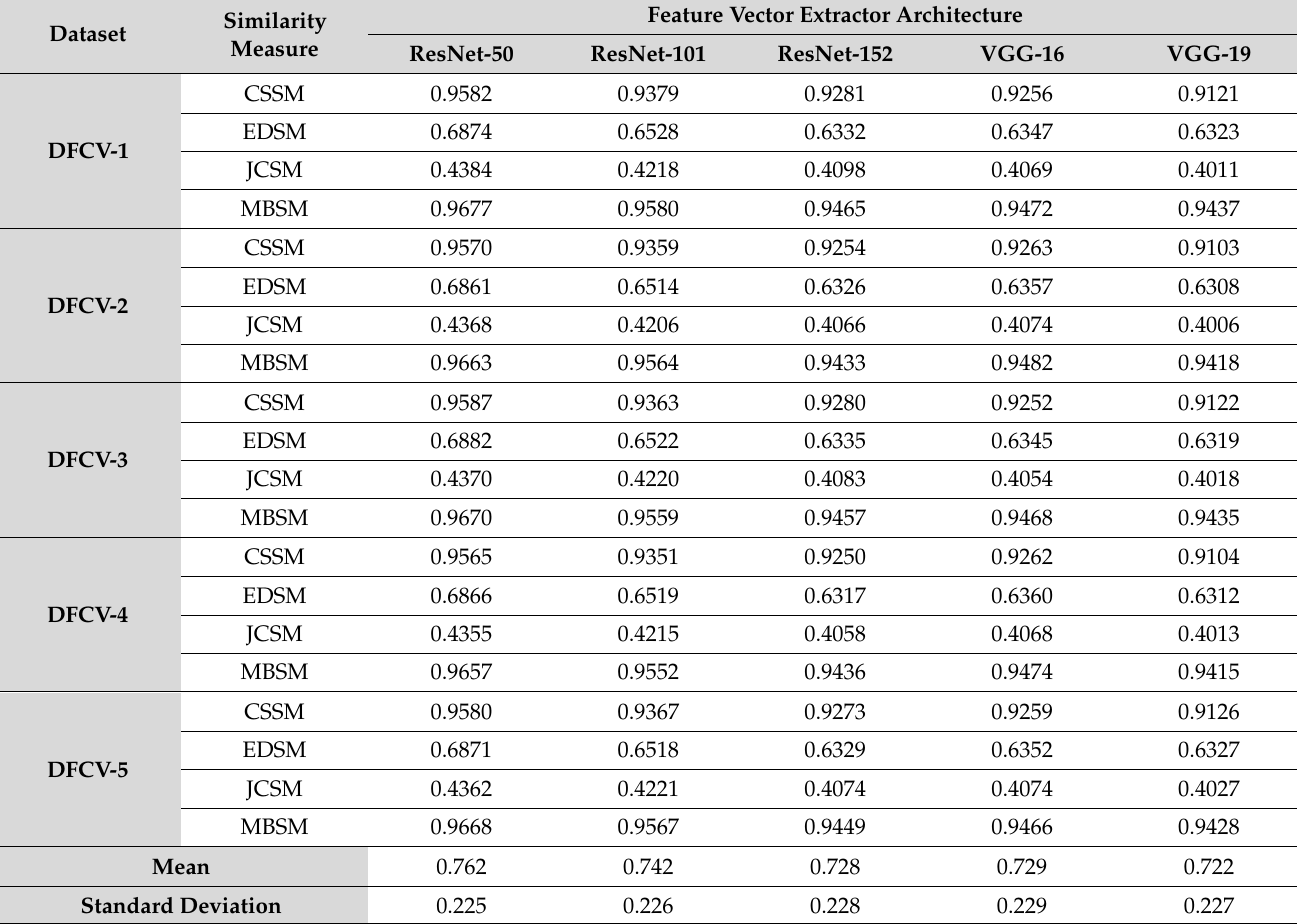
Table A2. Average highest cosine similarity (AHS) obtained for the CNN models with DFCV dataset.